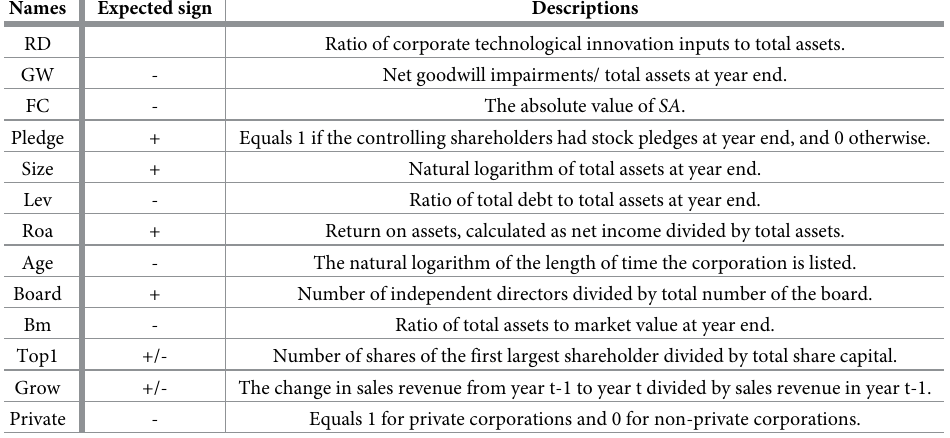
Table 1. Variable